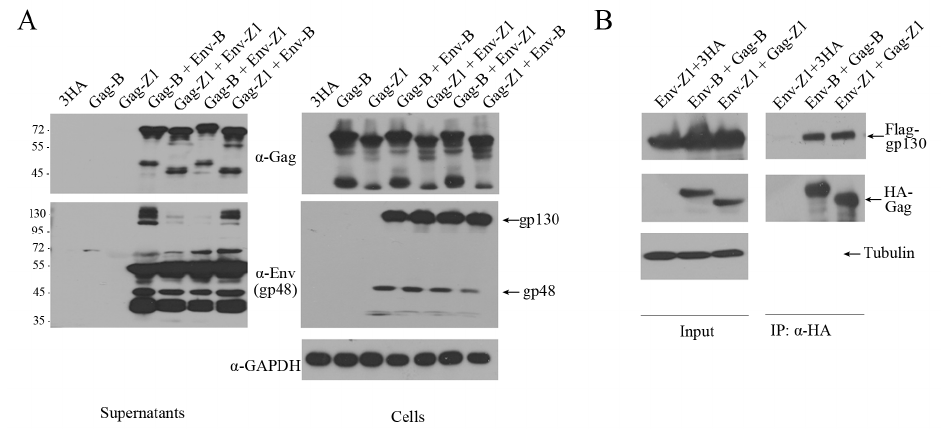
Figure 6. The interaction between Gag and Env. ( A ) HEK293T (4 × 10 6 ) cells were transfected with different eukaryotic expression plasmids, 3HA-Gag and 3HA-Env, for 2 days. Cells and supernatants were harvested separately, and the cell culture supernatants were cleared by ultracentrifugation following filtration with a 0.45 µ m membrane. Levels of Gag and Env in cells and supernatants were measured by western blotting. ( B ) Immunoprecipitation (with anti-HA) and immunoblot (with anti-HA and anti-Flag) of HEK293T (4 × 10 6 ) cells co-transfected with the same source of eukaryotic expression plasmids encoding 3HA-Gag and 3Flag-Env.